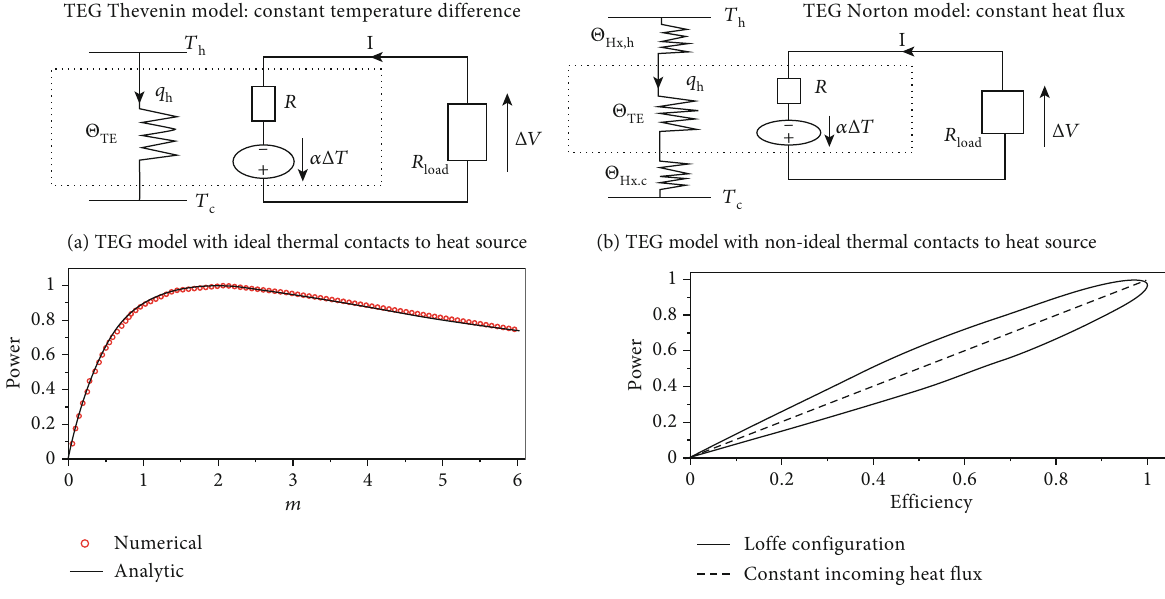
Figure 16: In fl uence of thermal environment on optimal working conditions of TEGs (adapted from [27]).